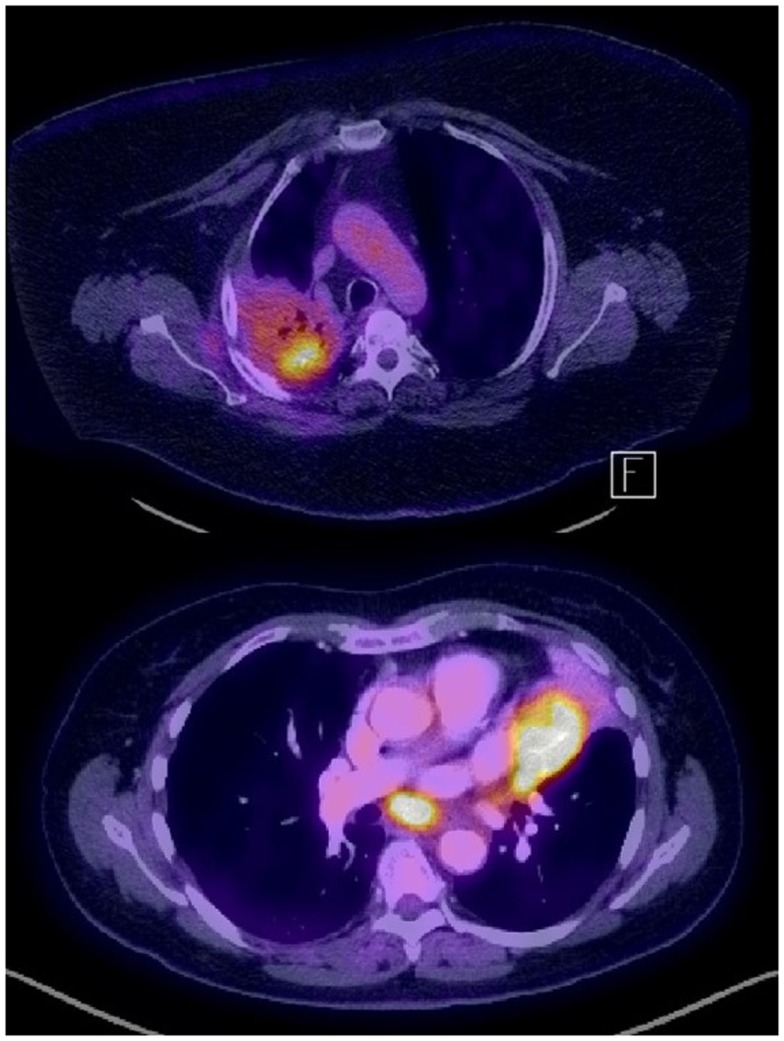
Examples of PET-avid NSCLC in the presence of fibrosis (recurrence after chemo-radiation, top) and atelectasis (bottom).